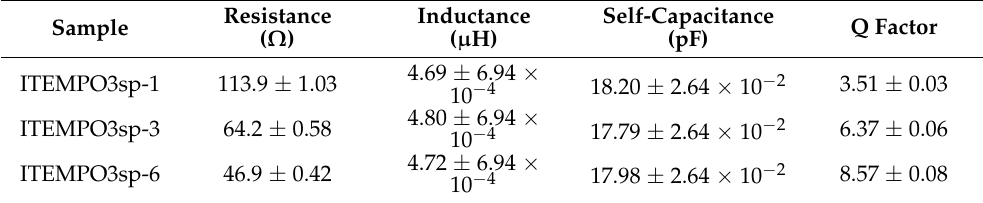
Table 4. Measurements of performance of printed NFC antennas.